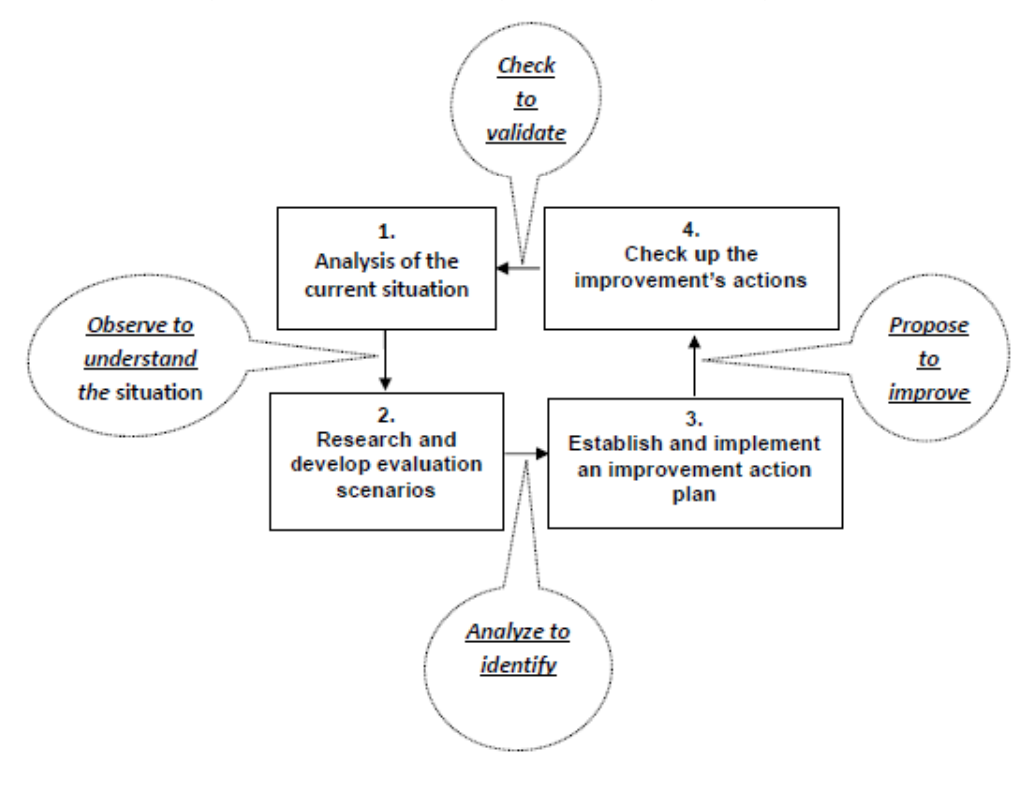
Figure. 1: Theoretical stages of the logistic diagnostic.